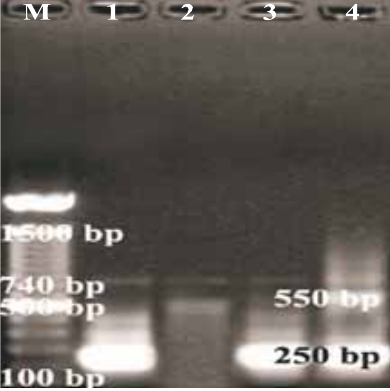
Figure-4: Nested PCR from L of Lane M : 100 bp DNA ladder, Lane 1 : Rohilkhand strain, Lane 2 : Jhansi strain, Lane 3 : Jaunpur strain, Lane 4 : Varanasi strain Table-1: Genotyping of larvae of H. contortus